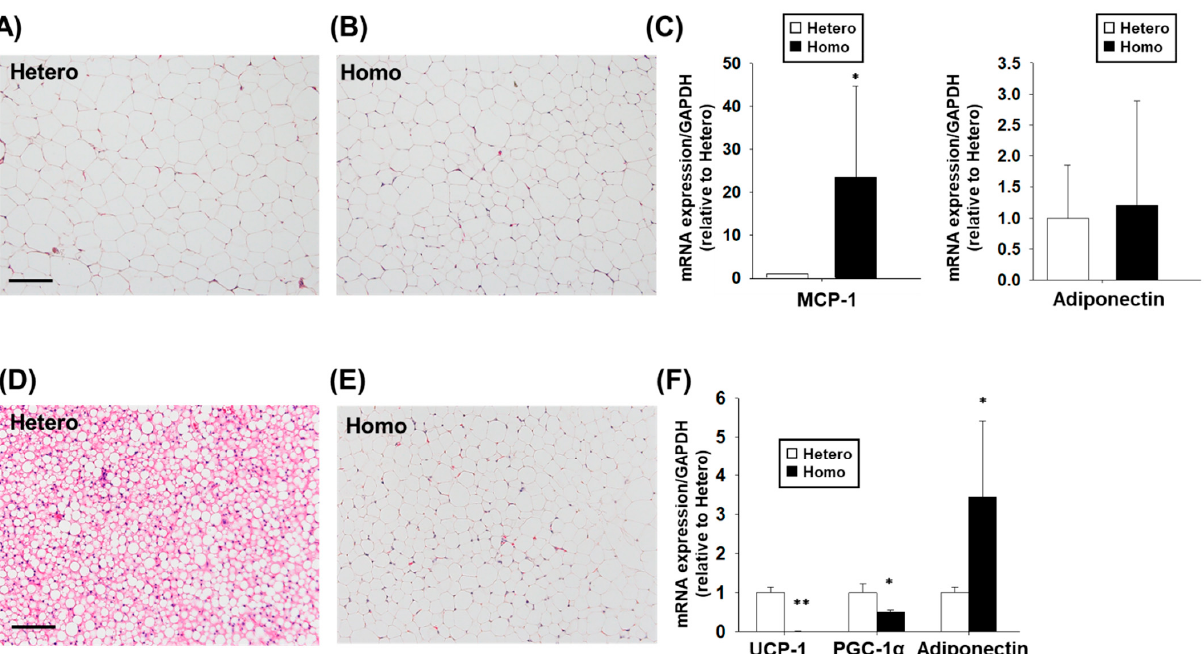
Figure 4. Morphology and mRNA expression in white adipose tissue (WAT) and brown adipose tissue (BAT). Thin sections (10 µ m) were made from paraffin-embedded isolated perirenal adipocytes (WAT) and interscapular adipocytes (BAT) from ZFDM rats at 36–38 weeks old (Hetero: n = 8, Homo: n = 9). ( A , B ) Representative HE-stained sections for WAT. ( C ) The mRNA expression levels of monocyte chemotactic protein (MCP)-1 and adiponectin in WAT were measured by a reverse transcription quantitative polymerase chain reaction (RT-qPCR). The data normalized to glyceraldehyde 3-phosphate dehydrogenase (GAPDH) mRNA was shown as fold increase relative to Hetero and expressed as means ± SEM. ( D , E ) Representative HE-stained sections for BAT. ( F ) The mRNA expression levels of uncoupling protein (UCP)-1, peroxisome-proliferator-activated receptor γ coactivator-1 α (PGC-1 α ), and adiponectin in BAT were measured by RT-qPCR. The data normalized to GAPDH mRNA was shown as fold increase relative to Hetero and expressed as means ± SEM. Scale bar: 200 μ m ( A and D ). * p < 0.05, ** p < 0.01 vs. Hetero.